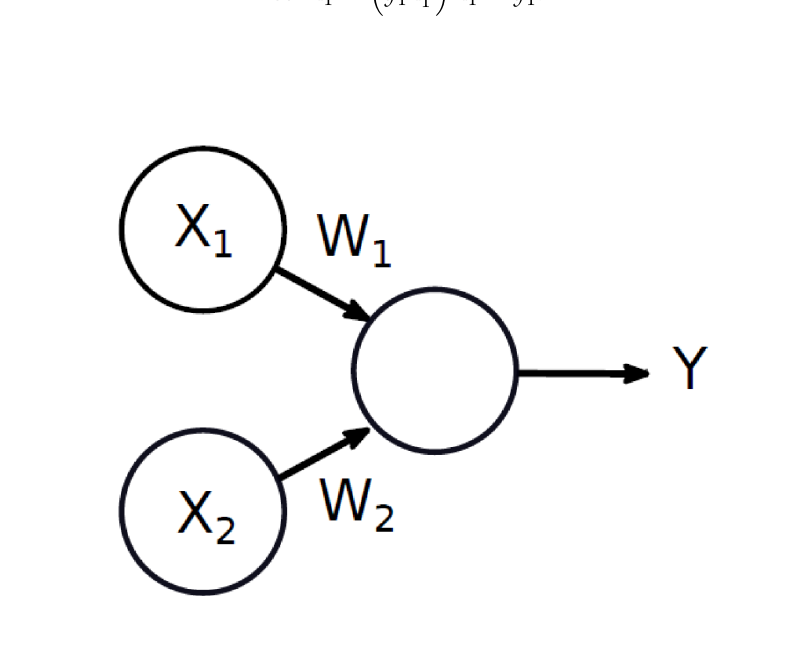
Figure A2. Sketch of a simple